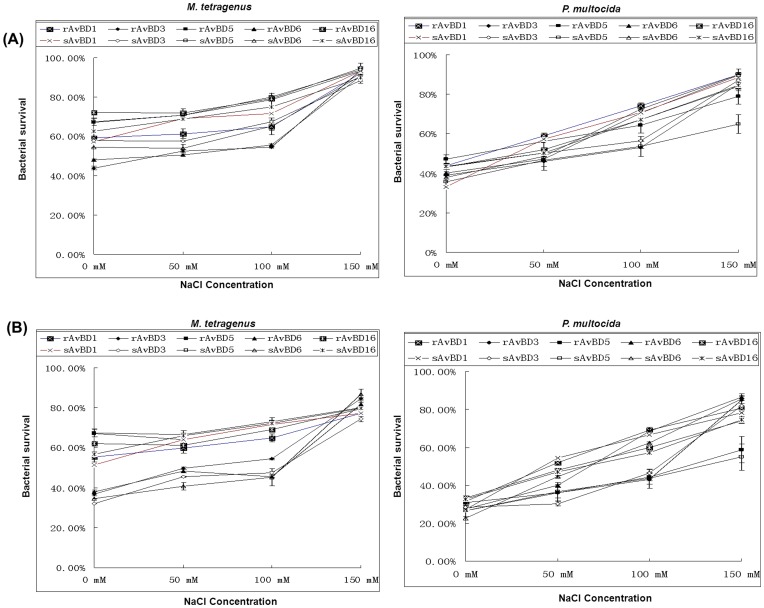
Effects of salinity on the antibacterial activity of Apl_avian β-defensins (Apl_AvBDs) against M. tetragenus or P. multocida.(A) 25 µg/mL Apl_AvBDs; (B) 100 µg/mL Apl_AvBDs. Apl_AvBDs were incubated separately with either M. tetragenus or P. multocida for 3 h in the presence of 0, 50, 100, and 150 mM NaCl. All assays were performed in three independent experiments with three replicates per experiment, and each bar represents the mean ± SD. The data were analyzed using SAS [24].